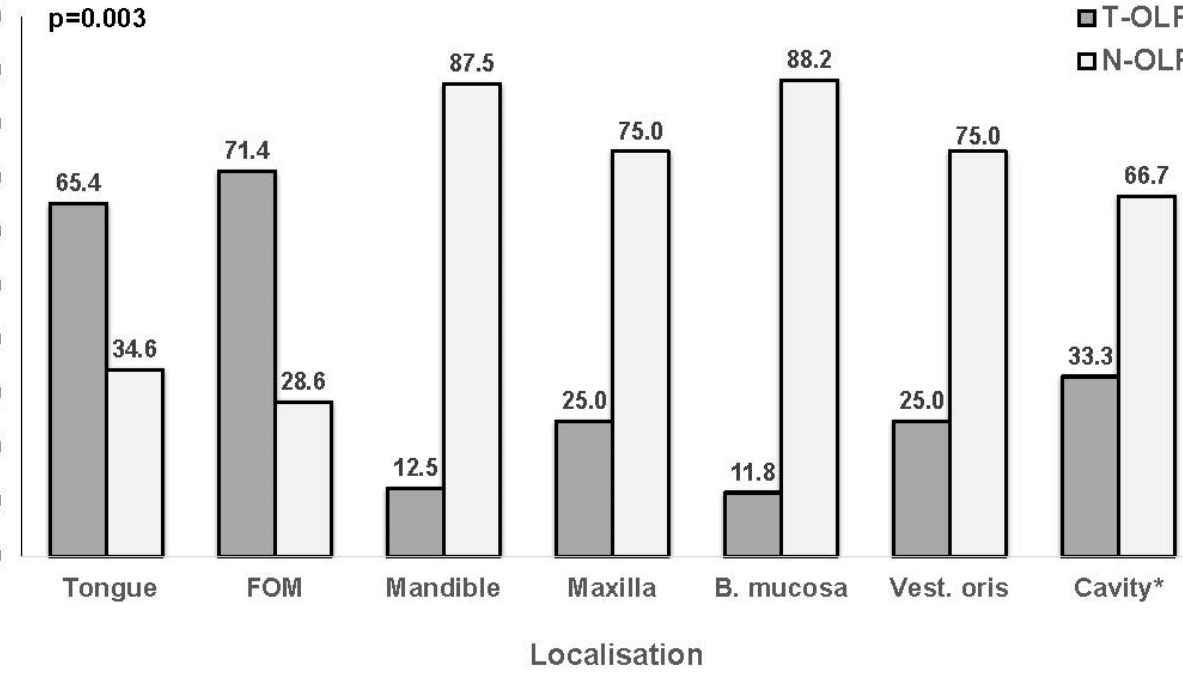
Figure 9. Relationship between localization and malignant transformation. OLP localized to the tongue and floor of the mouth (FOM) proceed into malignancy more frequently than those occurring in the mandible, maxilla, buccal mucosa (B. mucosa), vestibulum oris (Vest. oris) or other parts of the *oral cavity. Malignant transformation is significantly associated with the localization of the lesion ( χ 2-test).